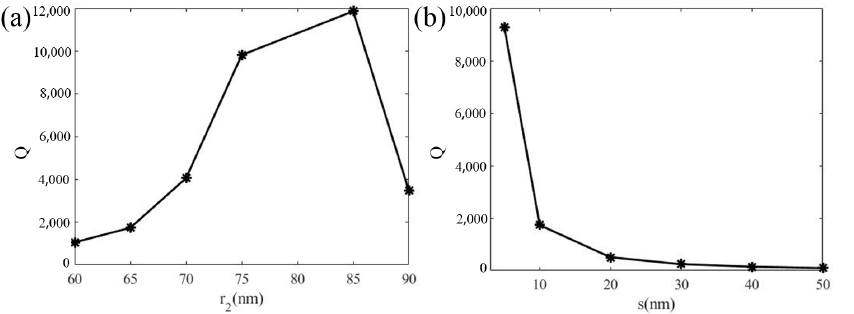
Figure 10. ( a ) Q versus different r 2 in BTO nanoparticles structure. ( b ) Q versus different s in thin film PMN-PT